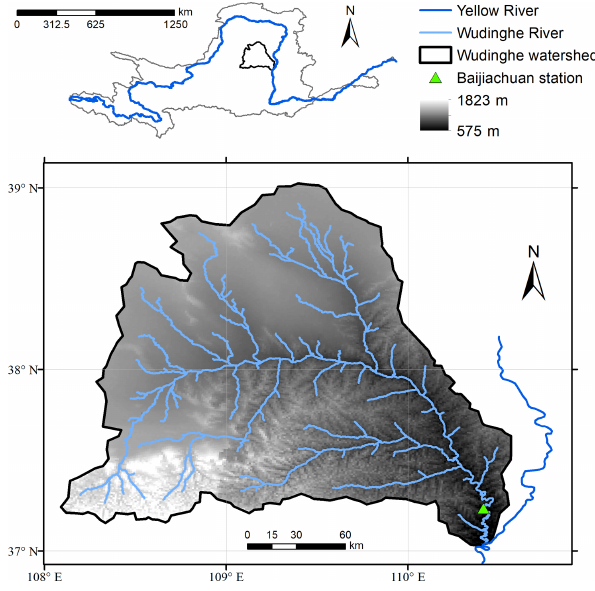
Figure 1. Location, elevation and river networks for the Wudinghe